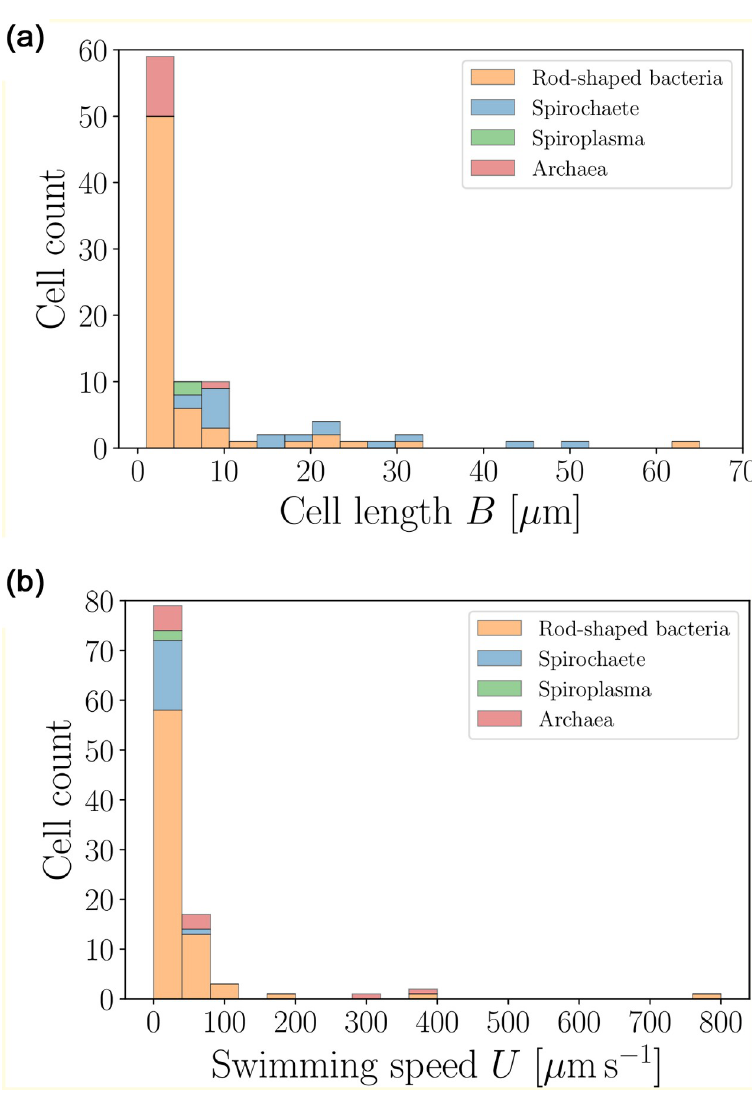
Fig 4. Histograms of body lengths, B ( μ m, left), and swimming speeds, U ( μ m s − 1 , right), for rod-shaped bacteria (excluding spirochaetes and Spiroplasma ) ( h B i = 5.79 ± 9.33 μ m ( n = 66), h U i = 48.33 ± 98.47 μ m s − 1 ( n = 77)), spirochaetes ( h B i = 18.59 ± 13.02 μ m ( n = 17), h U i = 17.94 ± 18.84 μ m s − 1 ( n = 15)), Spiroplasma ( h B i = 5.72 ±